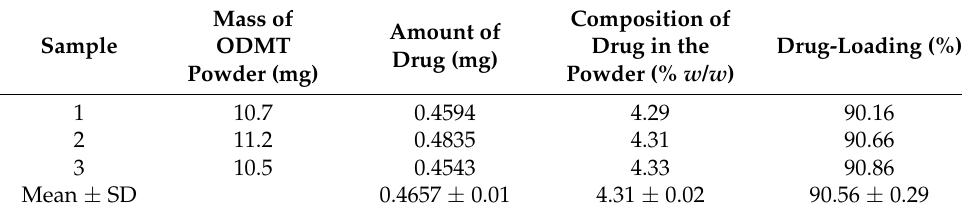
Table 13. Content assay results of CBZ ODMT